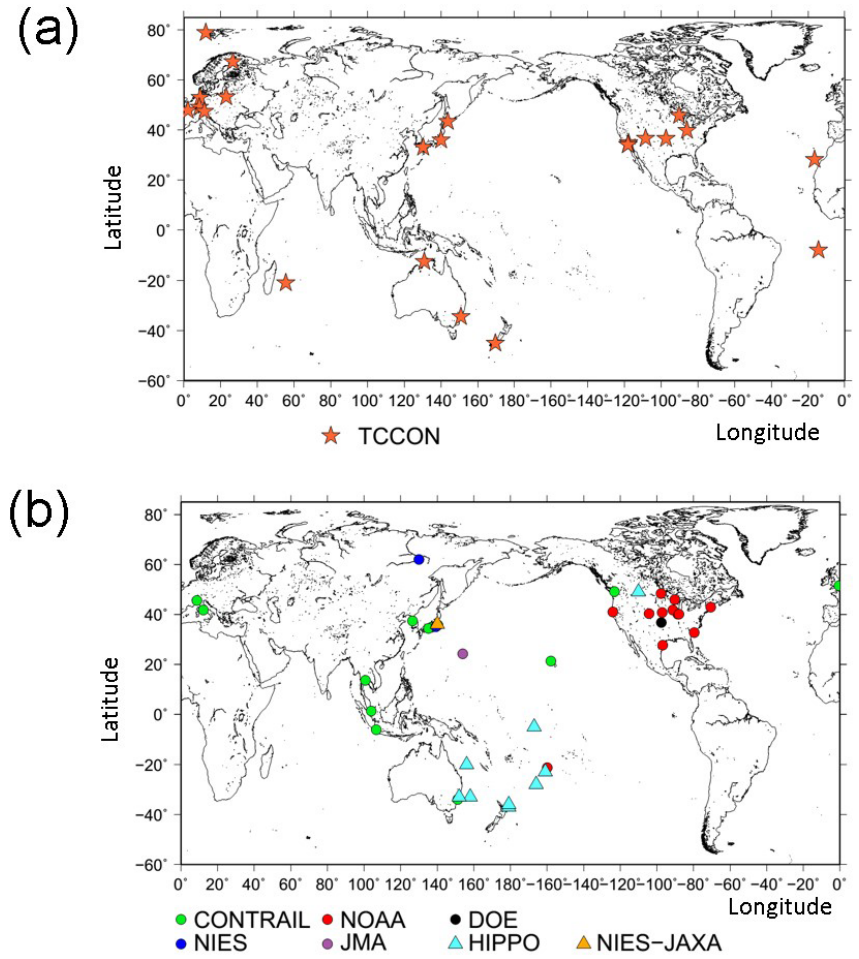
Figure 1. Global distributions of (a) the TCCON sites used for correction and validation of GOSAT data and (b) the aircraft observation sites used for validation of GOSAT